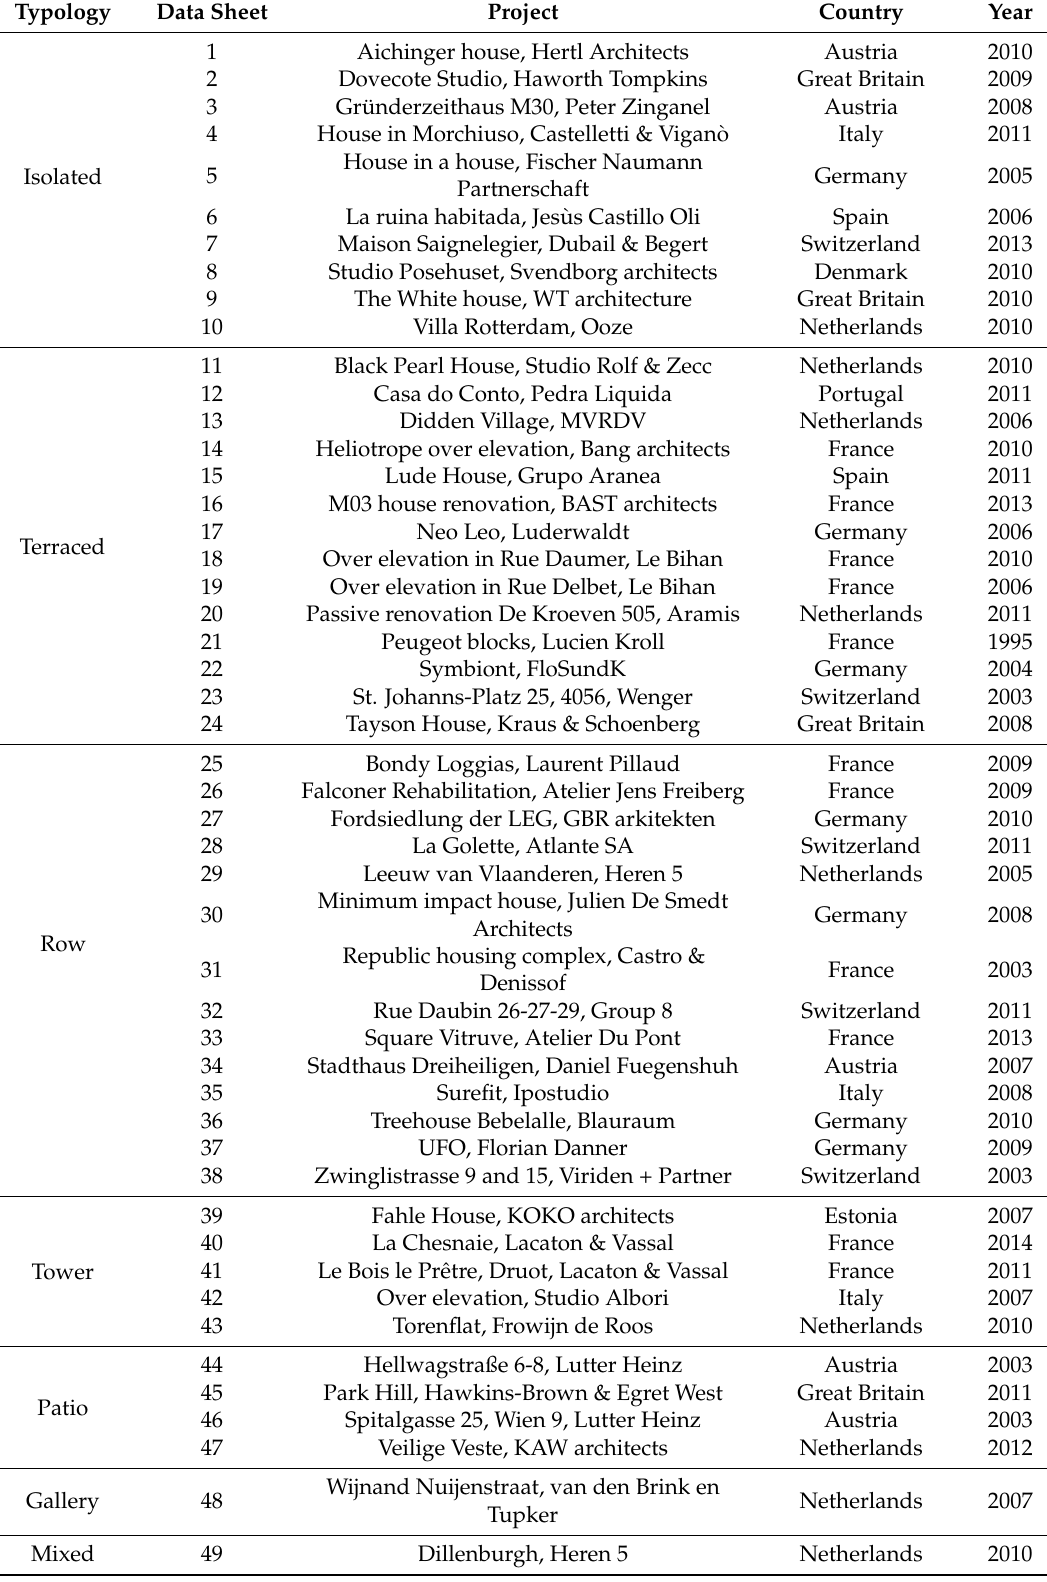
Table 1. Index of the data sheets related to the best